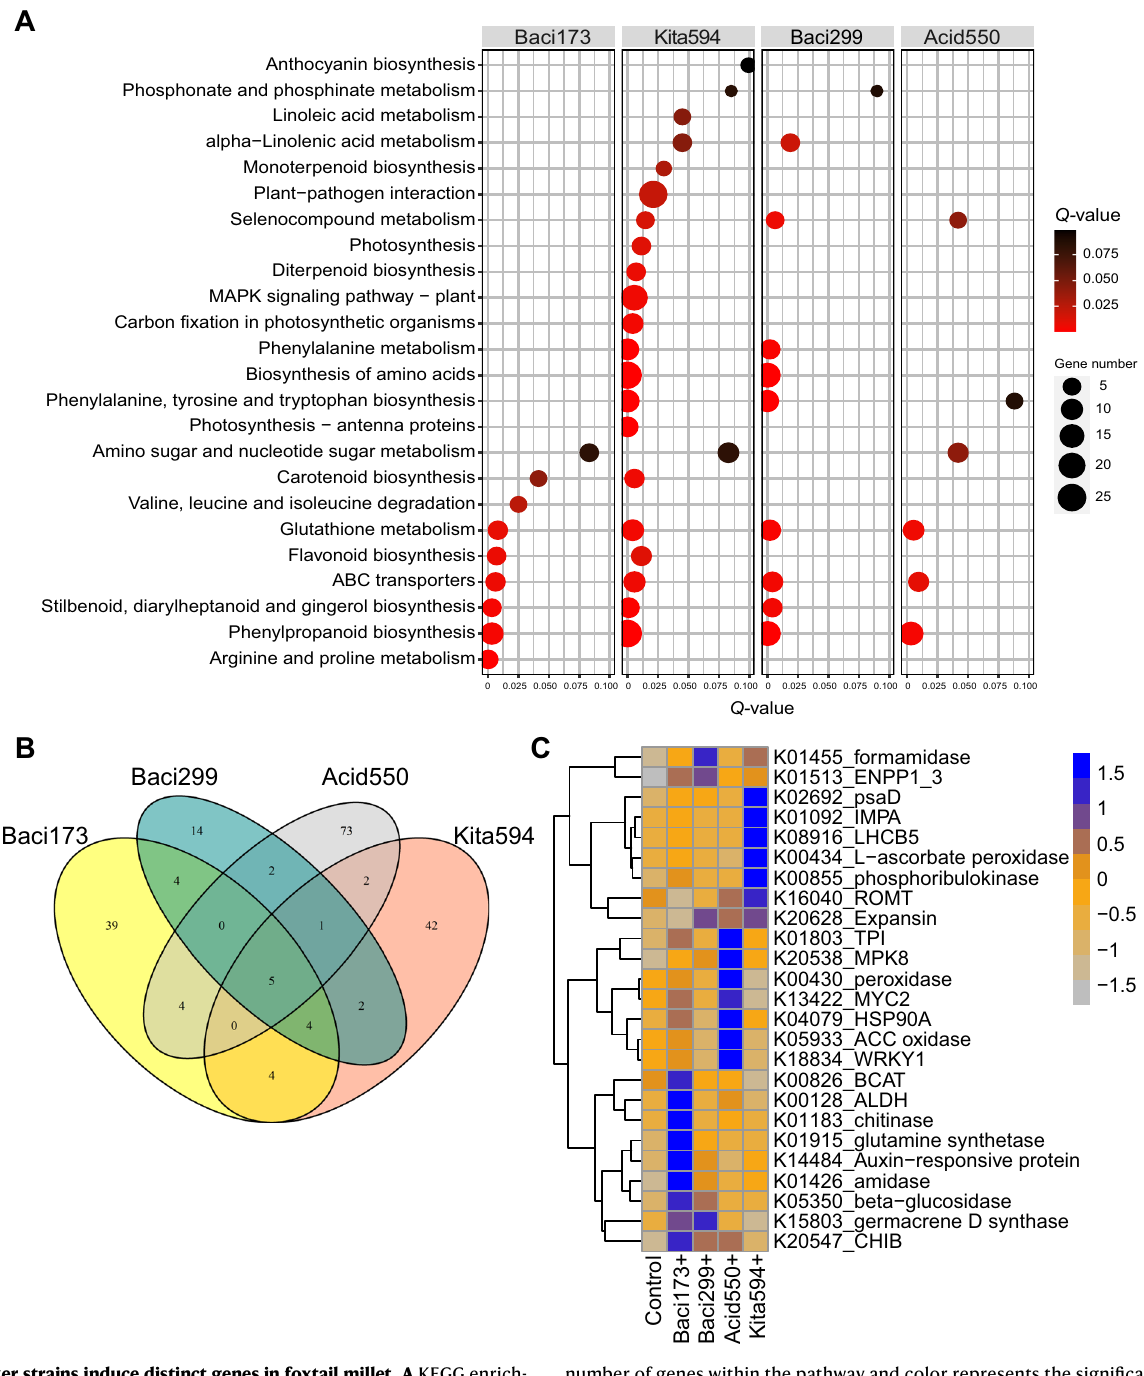
number of genes within the pathway and color represents the signi fi cance of the pathway. B Venn diagram showing the overlap of the signi fi cantly upre- gulated genes under different inoculations. C Transcript abundance of genes that were induced only in Baci173-, Baci299-, Acid550- and Kita594-inoculated seedlings,